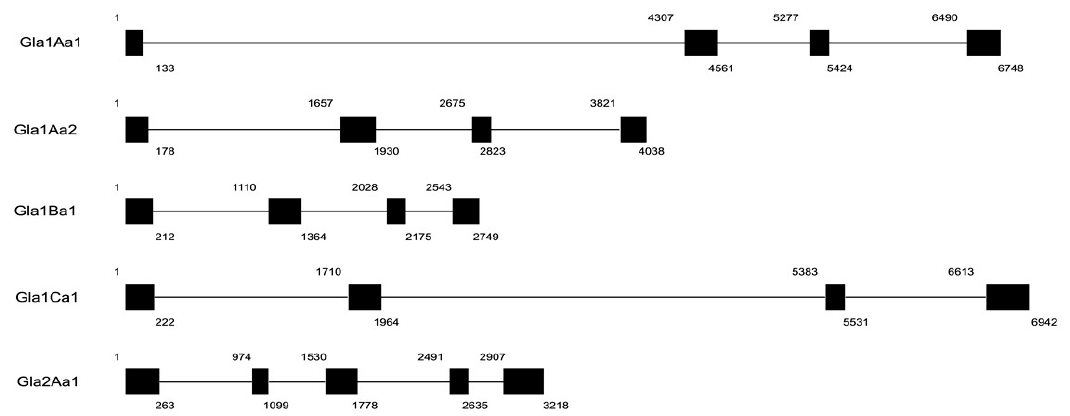
Figure 1. Schematic presentation of intron / exon structure of Glabralysin genes. Introns are shown as lines and exons as black boxes. Numbers in boxes represent the nucleotide position in the coding sequence.